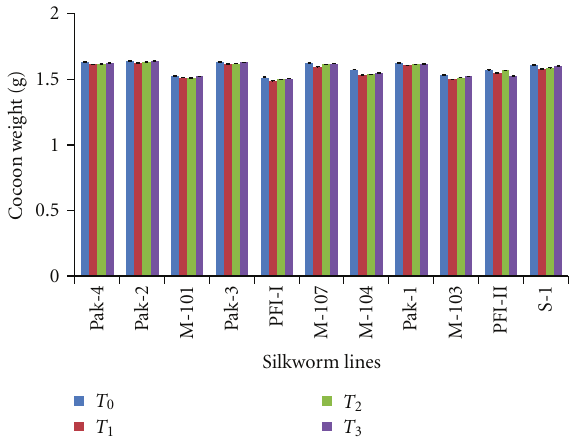
Figure 1: Comparative performance of cocoon weight (mean ± SE) of eleven silkworm lines at 25 ± 1 ◦ C in combination with 55, 65, and 75% RH and controlled conditions of temperature and RH (25 ± 1 ◦ C and 70–80%, resp.).